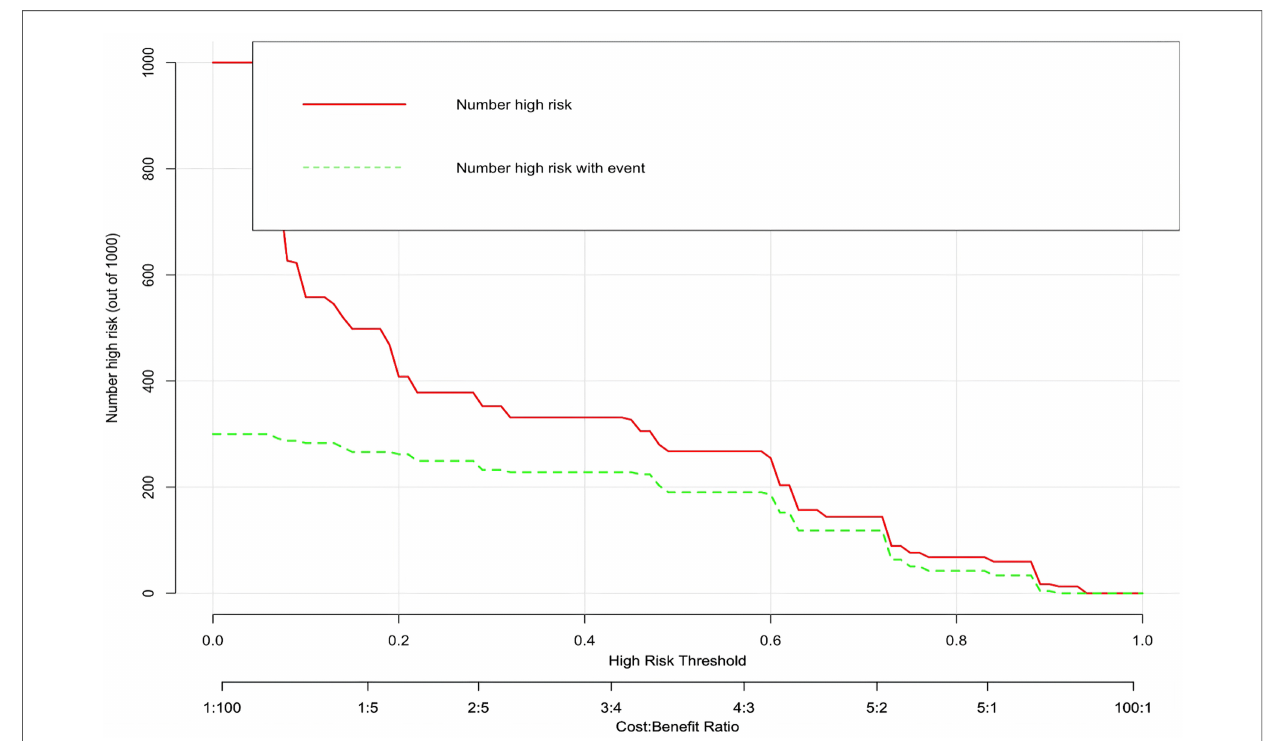
FIGURE 1 Establishment of nomogram risk model for predicting lower extremity DVT detachment in orthopedic